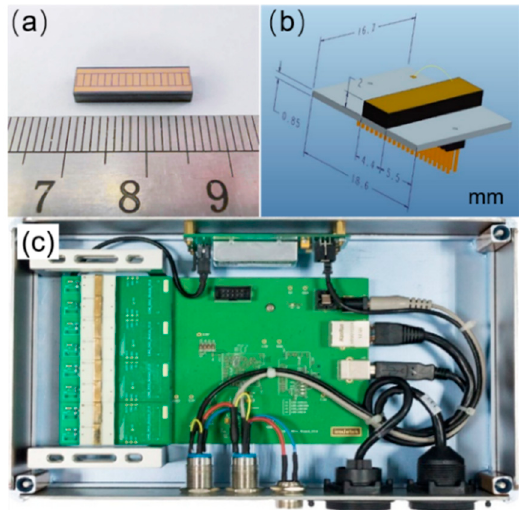
Figure 1. ( a ) Anode structure of linear array 1 × 16-pixel CdZnTe detectors; ( b ) packaging structure of CdZnTe photon counting detectors; ( c ) MXA-L256P readout system equipped with 8 CdZnTe photon counting detectors.